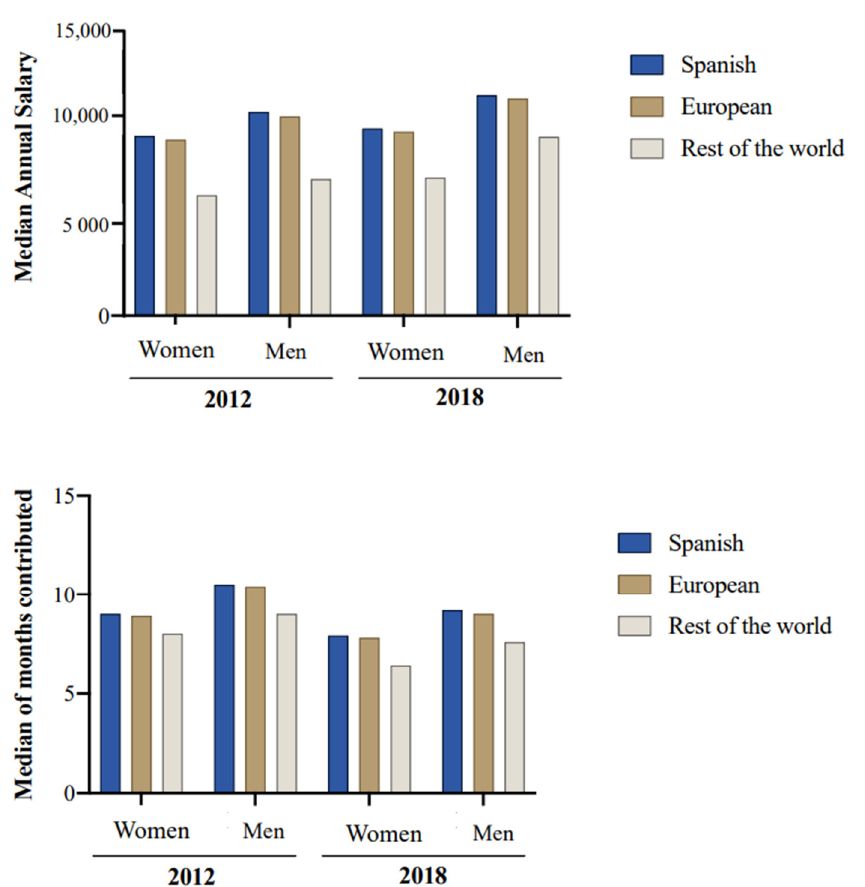
Figure 6. Median annual salary and month contributions of people aged 20 to 30 years by nationality, Spain 2012 and 2018. Source: Our own elaboration from the Spanish CPLS 2012 and 2018.